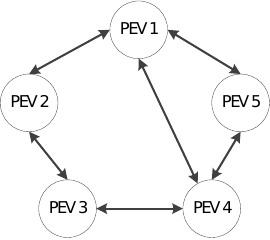
Figure 1. Communication topology of five plug-in electric vehicles (PEVs).